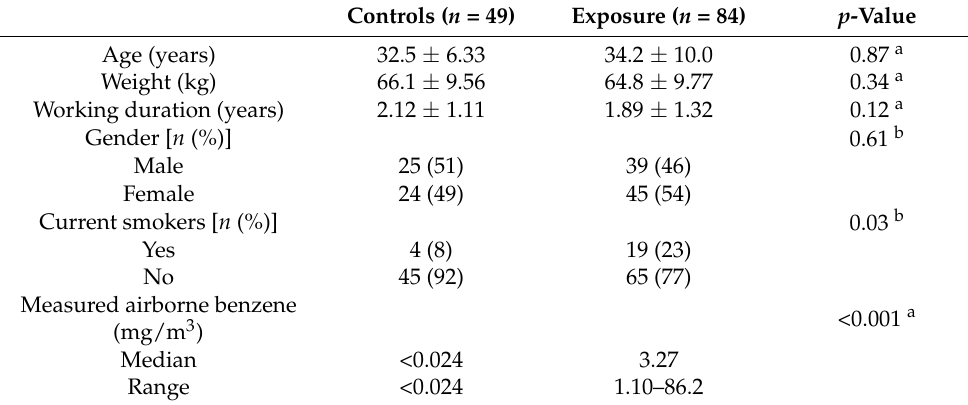
Table 1. Descriptive parameters of control and exposed